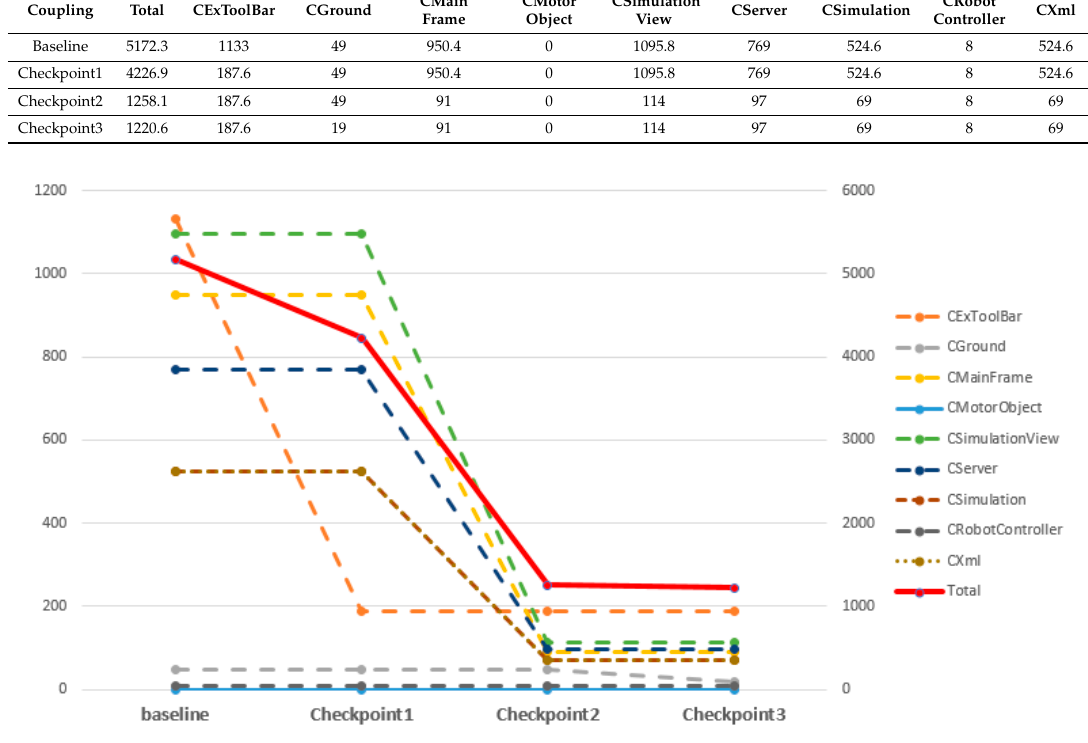
Figure 6. Refactoring results.